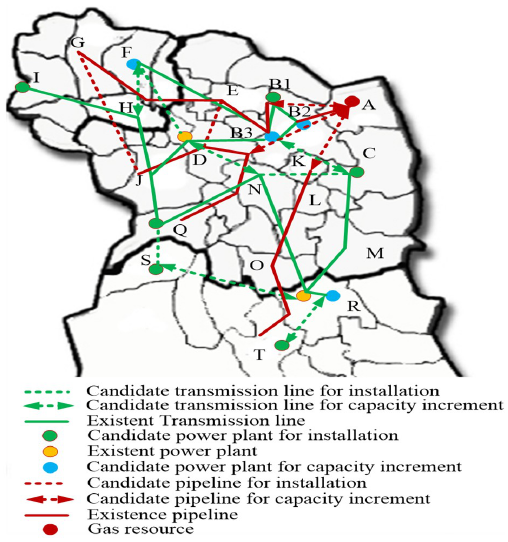
Figure 3. Khorasan gas–electricity system. Table 2. Investment cost of expansion candidates.